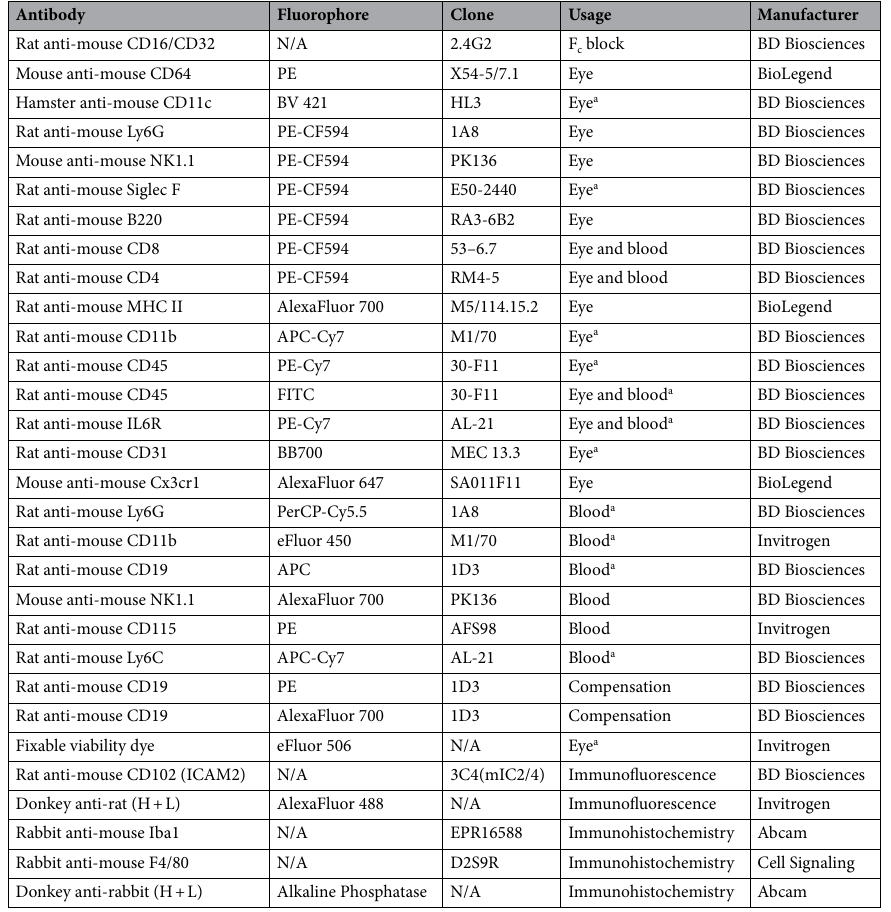
Table 1. Antibodies used in this study. a Antibody used for compensation